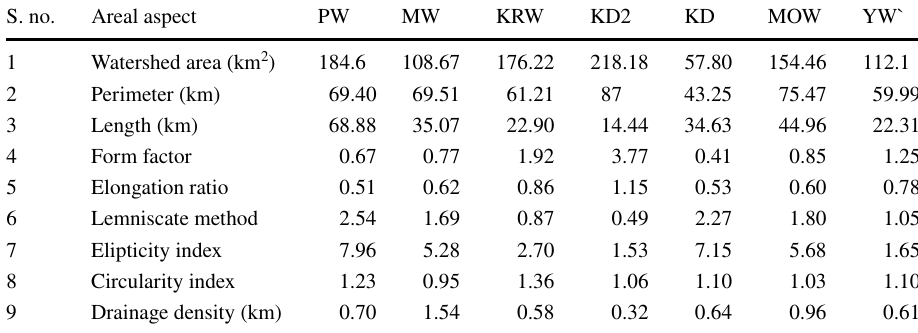
Table 4 Areal aspect of the Vaniyar sub